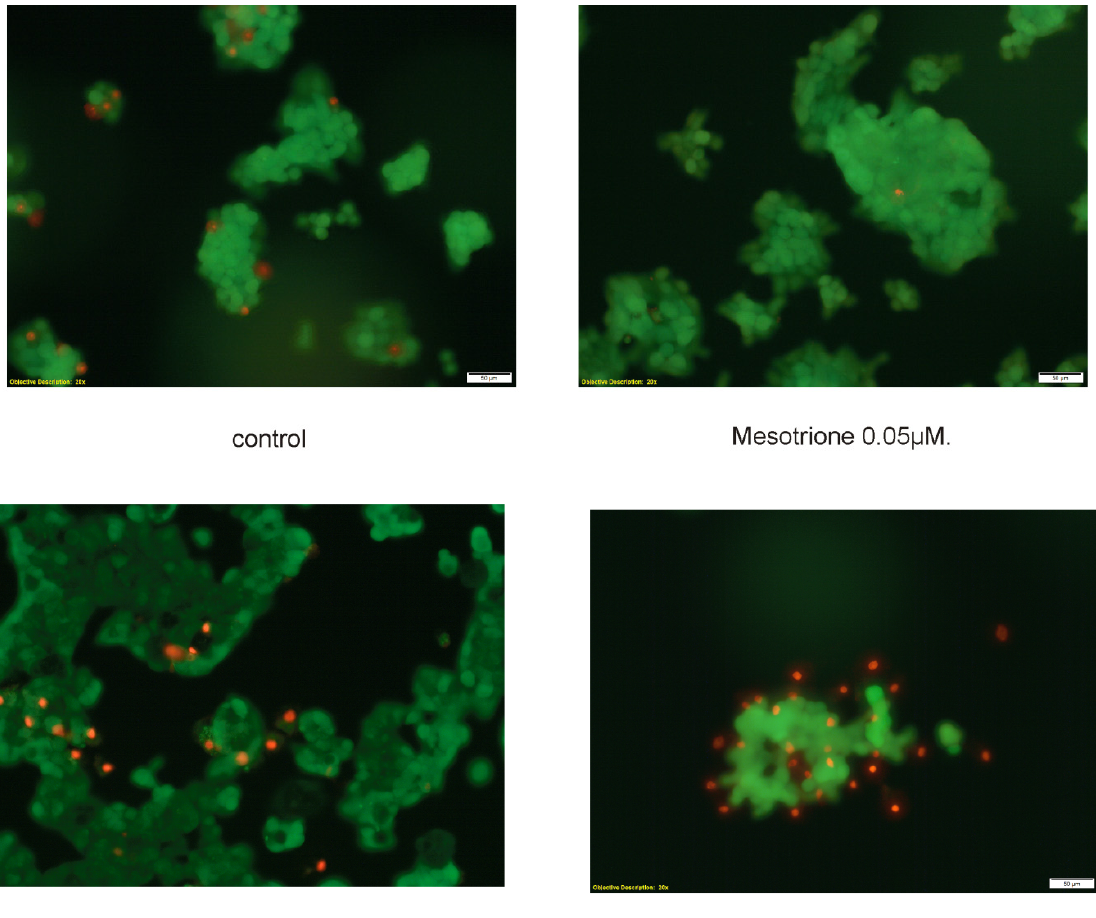
Figure 2. The effect of TA, Mes, and the combination of TA+Mes on apoptosis in ZR-75-1 cells, which were incubated with 100 µM of TA, 200 µM of TA, 0.05 µM of Mes, and a mix of 100µTA + 0.05 µM Mes, 200 µM TA + 0.05 µM Mes. ( A ) Caspase 3/7 activity in ZR-75-1 cells under the influence of TA, Mes and TA + Mes on, ( B ) Bar graphs presenting the percentage of apoptotic cells. Mean values from three independent experiments ± SD are shown. Different letters indicate statistical differences ( p ≤ 0.05) between treatments estimated by Tukey’s test.